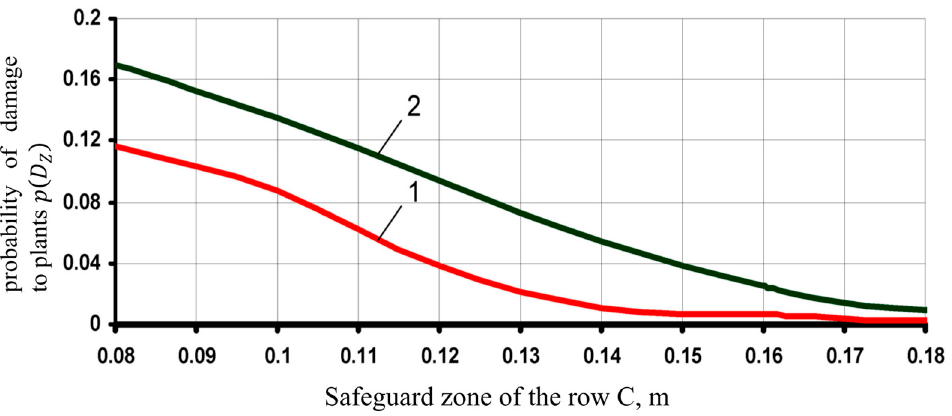
Figure 6. The probability of plant damage depending on the size of safeguard zone C : 1 — inner working implement; 2 — outer working